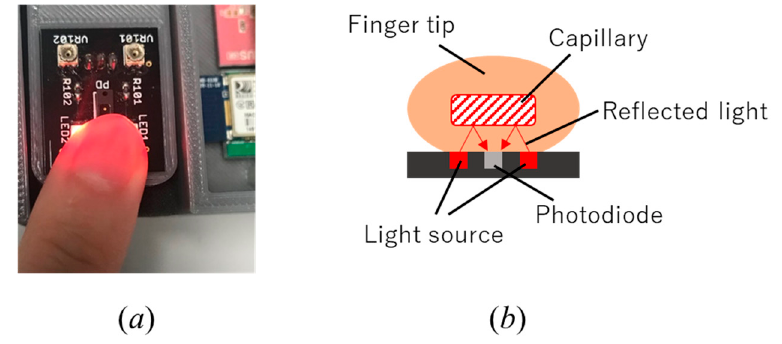
Figure 3. PPG sensor used in this study: ( a ) PPG sensor and measurement method and ( b ) simplified drawing of the PPG sensor.